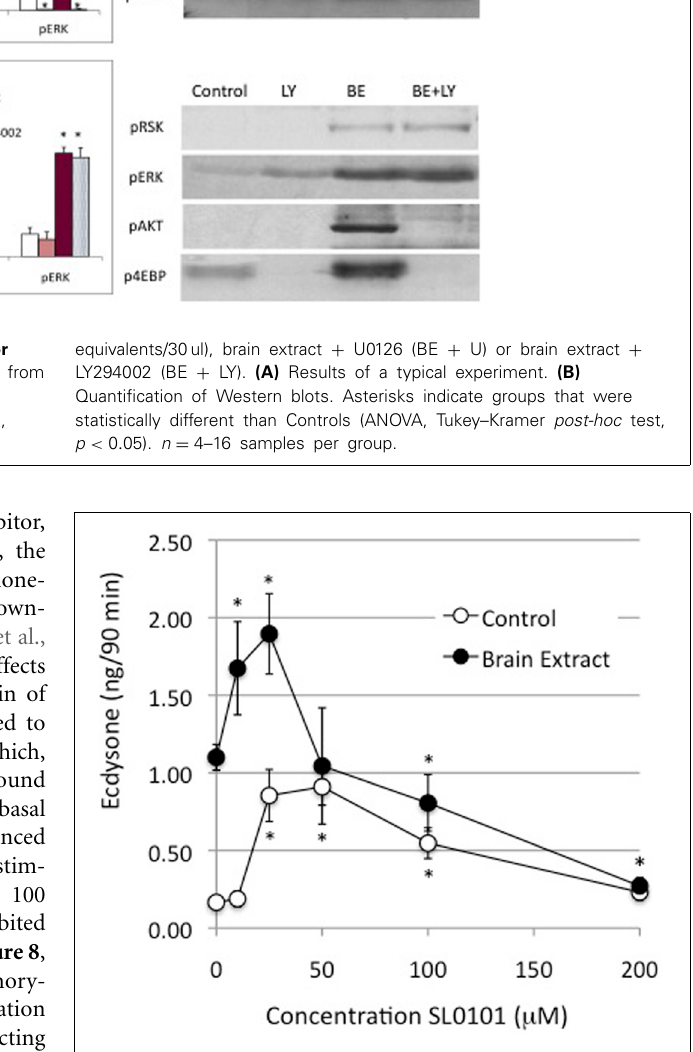
FIGURE 7 | Effects of RSK inhibitor (SL0101) on ecdysone secretion. Prothoracic glands from day 3 fifth instar larvae were incubated for 20min in medium with or without the designated doses of SL0101, followed by 90min in designated doses of SL0101 with or without brain extract (0.5 Brain equivalents/30 µ l). At the end of the incubation period culture medium was assayed for ecdysone by radioimmunoassay. Ecdysone secretion by groups treated with 10, 25, or 50 µ M SL0101 was statistically higher than groups incubated in the absence of inhibitor. Ecdysone secretion by groups treated with brain extract, and 100 or 200uM SL0101, was significantly lower than groups treated with brain extract in the absence of inhibitor. Asterisks = significant differences from groups incubated in the absence of inhibitor (ANOVA, Tukey-Kramer post-hoc test, p < 0 . 05). n = 8–21 glands per SL0101-treated group; Controls = 53 glands per group; BE = 53 glands per